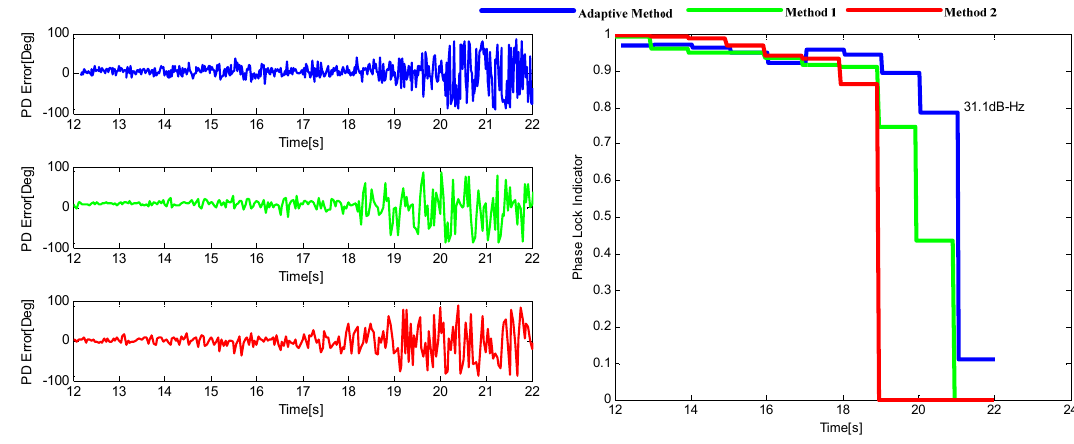
Figure 15. The output of PD ( left ) and the corresponding PLI ( right ) when p = 200 m/s 3 .